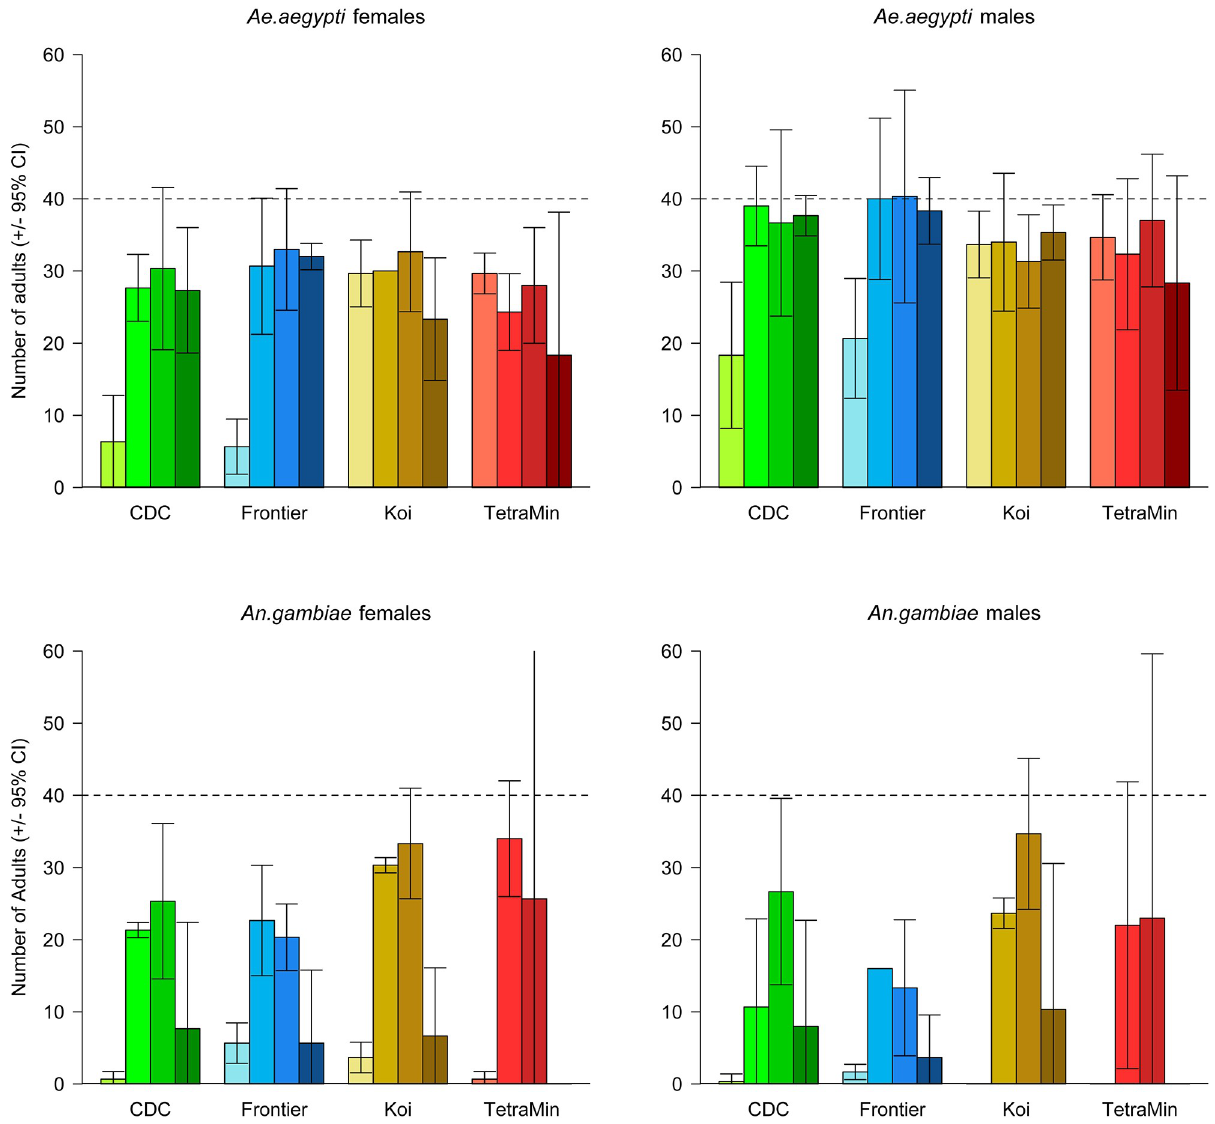
Fig 2. The number of Ae . aegypti and An . gambiae female and male adults observed by diet type and level. The dashed horizontal line indicates the expected number of females and males assuming a 1:1 sex ratio and full survival. Error bars are the 95% CI of the mean. Darkening shades of color represent the increasing diet levels of 8, 16, 32 and 64